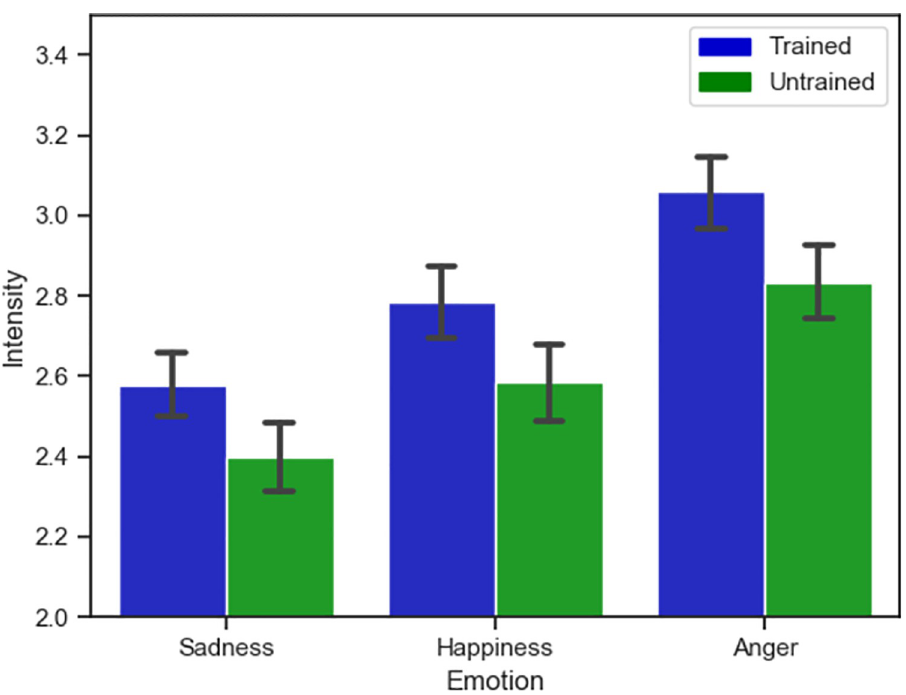
Fig 5. Training and intensity results. Significance of Training on Perceived Emotion Intensity. Y-axis represents a truncated scale, and error bars represent 95% confidence intervals.